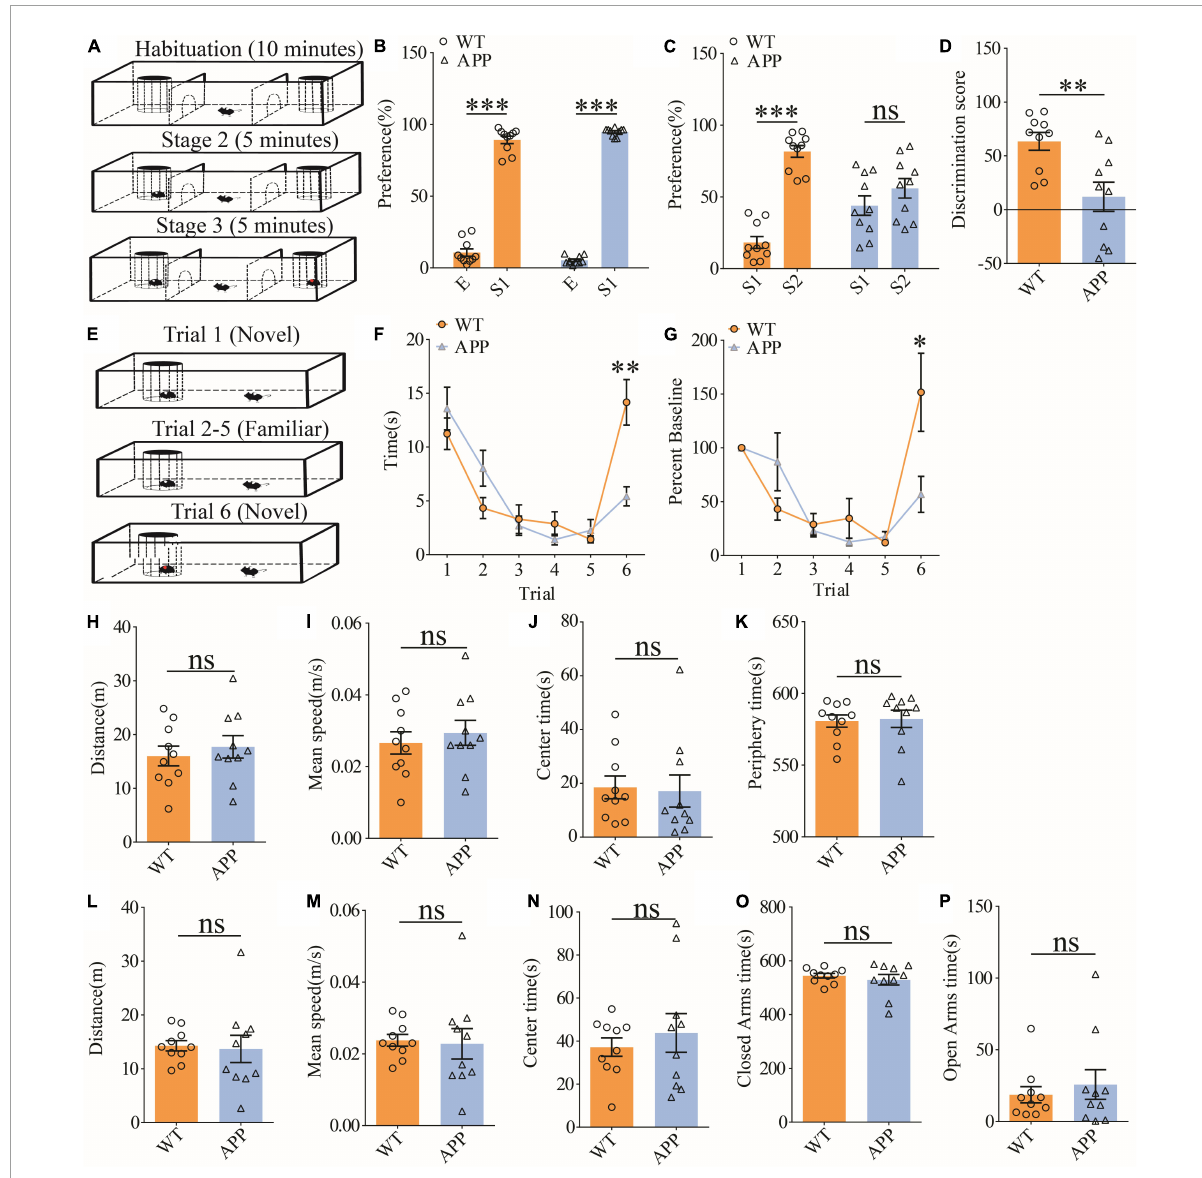
FIGURE6 Impaired social recognition memory in APP mice. (A) Schematic of the three-chamber social interaction test: stage 1 (habituation), stage 2 (social interaction), and stage 3 (social recognition memory). (B) Normal sociability during stage 2 in APP mice (WT: n = 10, p < 0.001; APP: n = 10, p < 0.001; two-tailed paired t -test). (C) Impaired preference for S2 over S1 during stage 3 in APP mice (WT: n = 10, p < 0.001; APP: n = 10, p = 0.227; two-tailed paired t -test). (D) Discrimination scores during stage 3 showing impaired social memory in APP mice ( p = 0.005, two-tailed t -test). (E) Schematic of the five-trial social memory test. (F) Both WT and APP mice showed gradual habituation for the first stranger during trials 1–5 (WT: n = 10, APP: n = 10; genotype group: F ( 1 , 9 ) = 0.016, p = 0.901; trial: F ( 4 , 36 ) = 9.313, p < 0.001; repeated two-way ANOVA). On trial 6, APP mice spent significantly less time interacting with the novel stranger compared to WT mice ( p = 0.002, two-tailed t -test). (G) Normalized interaction time in the five-trial social test (WT: n = 10, APP: n = 10; genotype group: F ( 1 , 9 ) = 0.298, p = 0.598; trial: F ( 4 , 36 ) = 8.517, p < 0.001; repeated two-way ANOVA). On trial 6, APP mice showed significantly decreased time interacting with the novel stranger compared to WT mice ( p = 0.029; two-tailed t -test). (H) Open field test showing similar travel distance in WT and APP mice (WT: n = 10, APP: n = 10, p = 0.548, two-tailed t -test). (I) Comparable travel speed between WT and APP mice during open field test (WT n = 10, APP n = 10, p = 0.556, two-tailed t -test). (J) Comparable time spent in center arena between WT and APP mice during open field test (WT: n = 10, APP: n = 10, p = 0.849, two-tailed t -test). (K) Comparable time spent in peripheral area between WT and APP mice during open field test (WT: n = 10, APP: n = 10, p = 0.835, two-tailed t -test). (L) Comparable travel distance between WT and APP mice during elevated plus maze test (WT: n = 10, APP: n = 10, p = 0.830, two-tailed t -test). (M) Comparable travel speed between WT and APP mice during elevated plus maze test (WT: n = 10, APP: n = 10, p = 0.830, two-tailed t -test). (N) Comparable time spent in center zone in elevated plus maze test between WT and APP mice during elevated plus maze test (WT: n = 10, APP: n = 10, p = 0.518, two-tailed t -test). (O) Comparable time spent in closed arms between WT and APP during elevated plus maze test (WT: n = 10, APP: n = 10, p = 0.496, two-tailed t -test). (P) Comparable time spent in open arms in between WT and APP mice during elevated plus maze test (WT: n = 10, APP: n = 10, p = 0.549, two-tailed t -test). * P < 0 . 05, ** P < 0 . 01, and *** P < 0 .